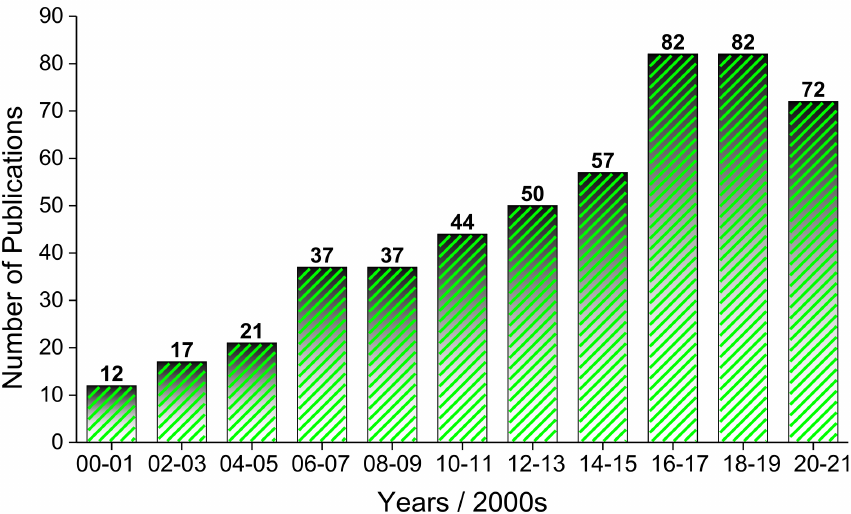
Figure 5. Number of publications related to catalytic processes involving Niobium catalysts since